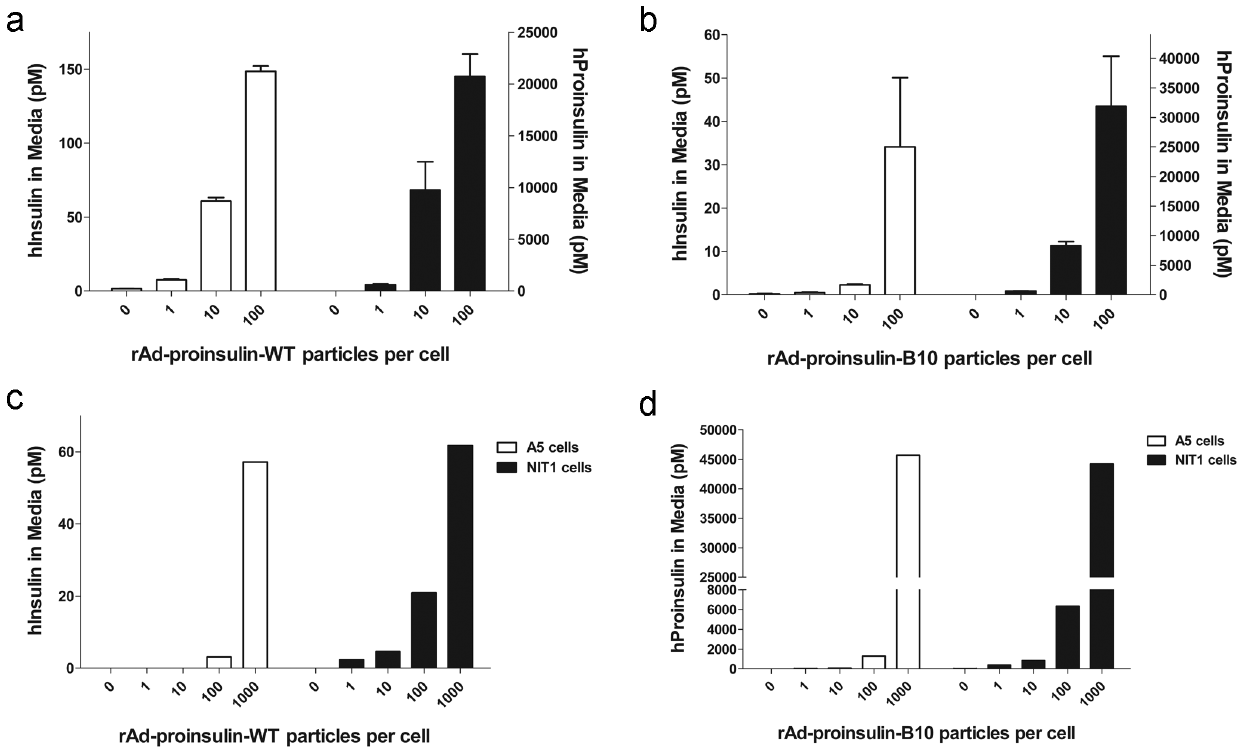
Figure 1. Human insulin and proinsulin secretion following invitro transduction with rAd-proinsulin-WT or rAd-proinsulin-B10. ( a, b ) HEK293 cells were transduced with rAd-proinsulin-WT ( a ) or –B10 ( b ) as indicated and media samples were assayed 24 hr later for both hInsulin and hProinsulin expression. Bars indicate mean + SEM concentration of hInsulin (open bars, left axes) or of hProinsulin (filled bars, right axes) for n=3 samples per group. ( c,d ) Rat A5 salivary gland cells and mouse NIT1 pancreatic beta-cells were transduced with rAd-proinsulin-WT ( c ) or –B10 ( d ) particles at the doses indicated. Media were collected 24 h later and insulin species were quantified by ELISAs. Bars indicate mean concentration of hInsulin ( c ) or hProinsulin ( d ) in the media of n=2 samples.